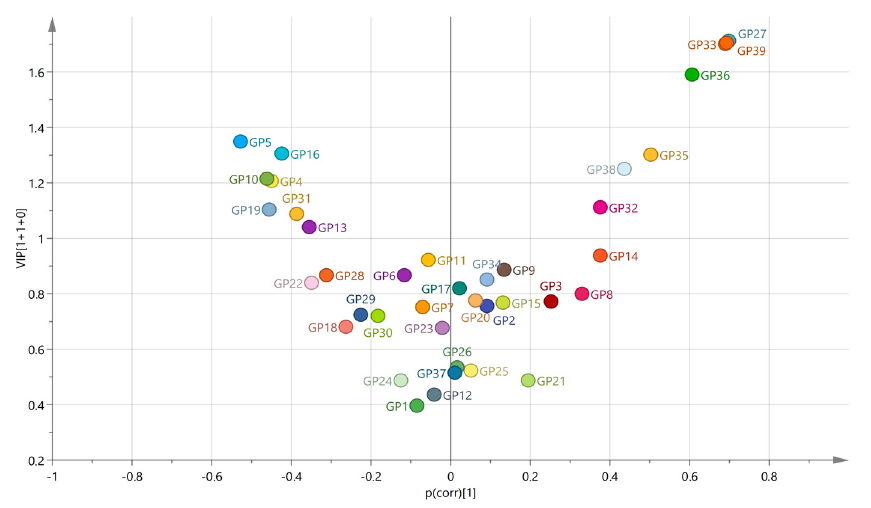
Figure 2. Volcano plot plotting the variable importance in the projection (VIP), acquired in the OPLS-DA model, against the correlation coefficient values (p(corr)) for all included variables between the PTSD patients and the control participants. Colored according to the identifiers.